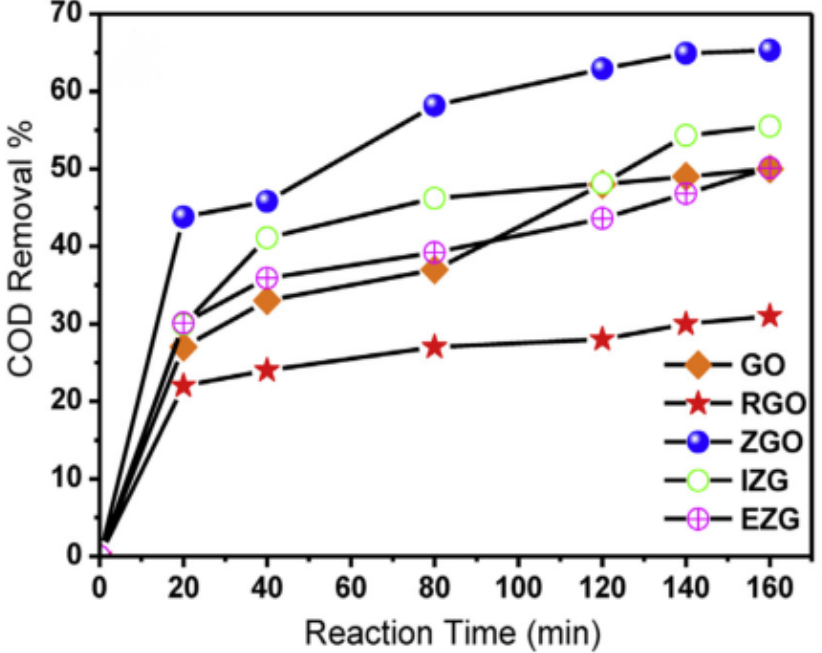
Figure 9. The synthesis of zno nanorods, go reduced go and their nanocomposites. Ahmed F. Ghanem et al. [62] decorated the graphene surface with 5% zinc oxide nanorods and evaluated the demineralization of synthetic wastewater by chemical oxygen demand, the photocatalytic activity of the obtained nanocomposite was 30% and 35% higher than that of pure reduced and reduced graphene oxide as Figure 10 shown. This increase in efficiency can be attributed to the synergy between the planar structure of zinc oxide and graphene, resulting in the development of an unprecedented polycrystalline structure.